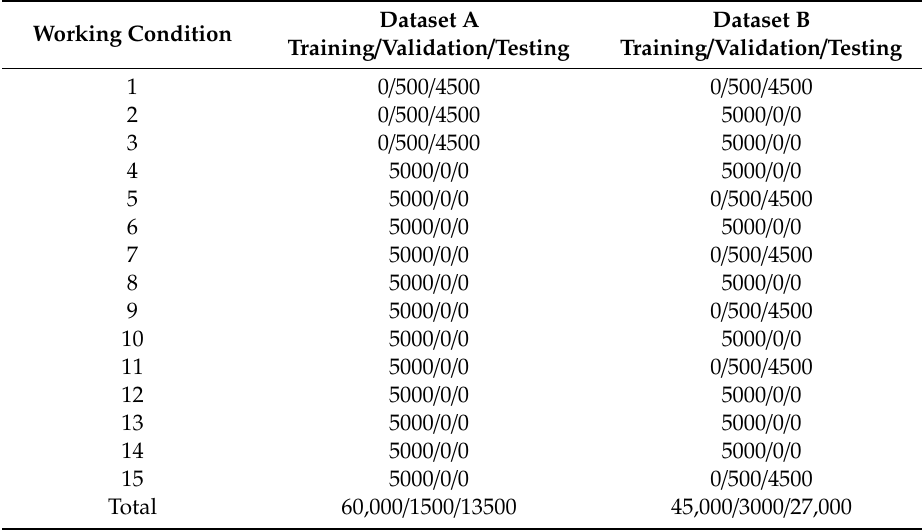
Table 10. Details of the two datasets in Case Two.